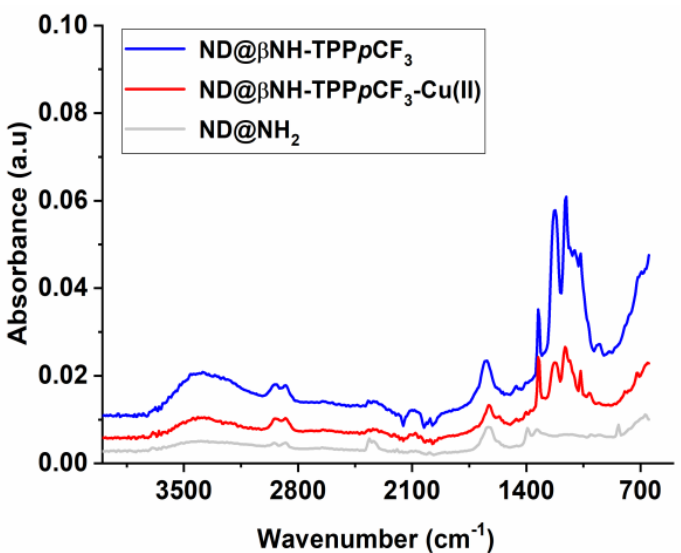
Figure 3. FT-IR spectra of ND@NH 2 (grey line), ND@ β NH-TPP p CF 3 -Cu(II) (red line) and ND@ β NH- TPP p CF 3 (blue line).